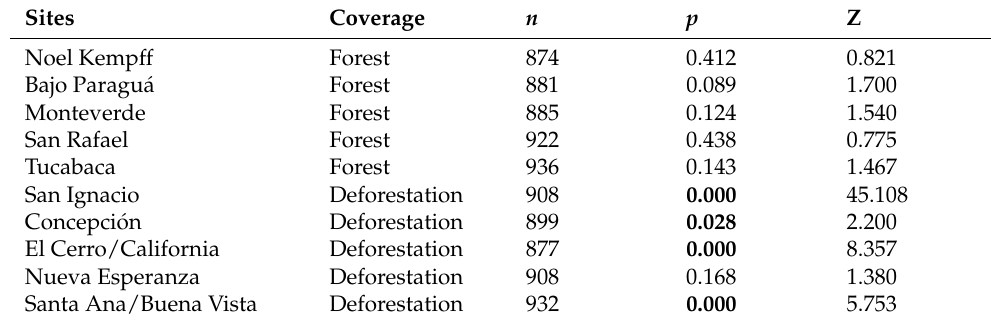
Table 3. Daytime LST trends ( ◦ C) for the ten study sites in the Chiquitania region. n—MODIS data series, p—statistical significance < 0.05 (highlighted in bold), Z—nonparametric Mann–Kendall test. Sites Coverage n